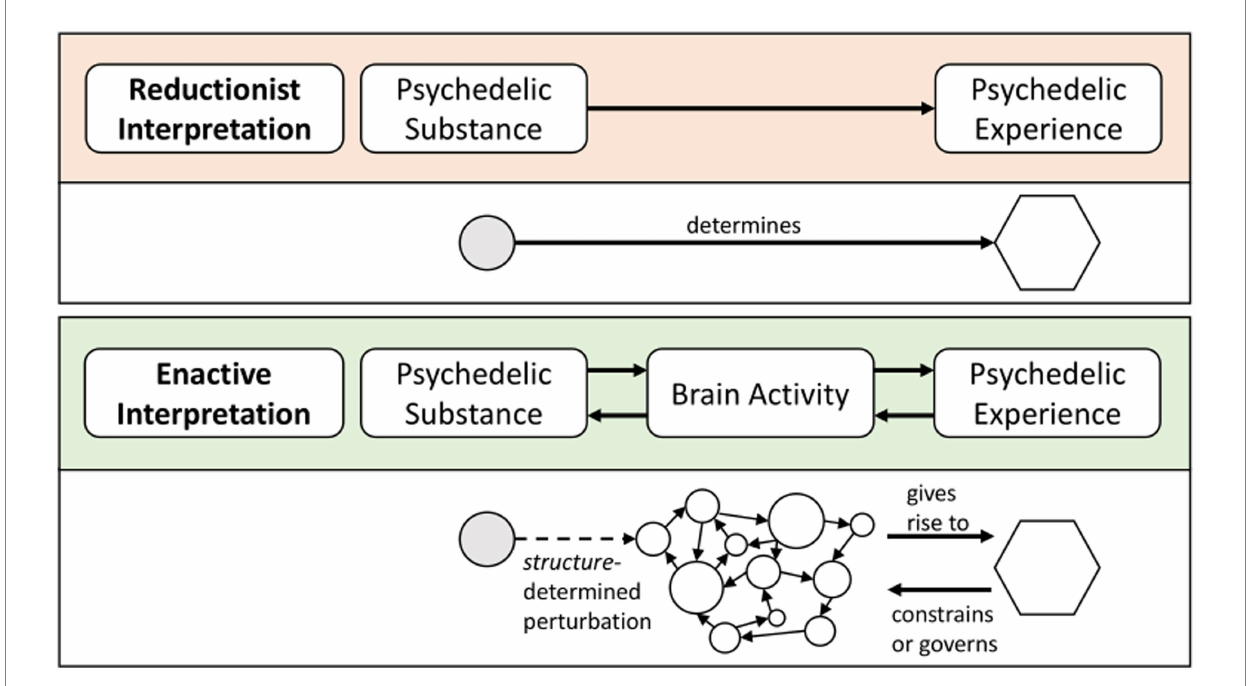
FIGURE 2 The psychedelic substance-experience link in a reductionist interpretation versus an enactive interpretation. In the enactive interpretation panel, links to the social and cultural environment are left out for conciseness purposes. However, the enactive approach includes an emphasis on the multiple interdependencies with the